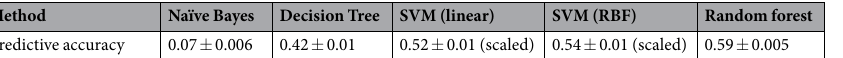
Table 2. Comparison of different machine learning methods. Average accuracy and standard deviation from 10-fold stratified cross-validation on full data (181 parameters). The SVMs used scaled parameter values; other methods used original values.